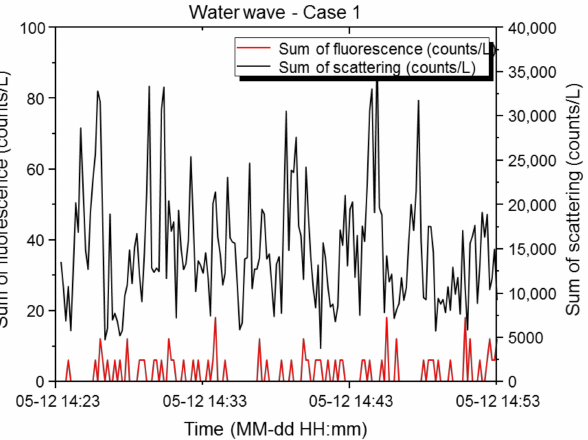
Figure 8. Results of scattered light and fluorescence measurements of the biological particle detector at a beach with crashing waves. Time-dependent concentrations of light scattering and fluorescent particles in Case 1. The X-axis represents the measurement period, and the Y-axis represents the measured particle concentrations. The black line represents the scattered light sum (counts/L), and the red line represents the fluorescence sum (counts/L).